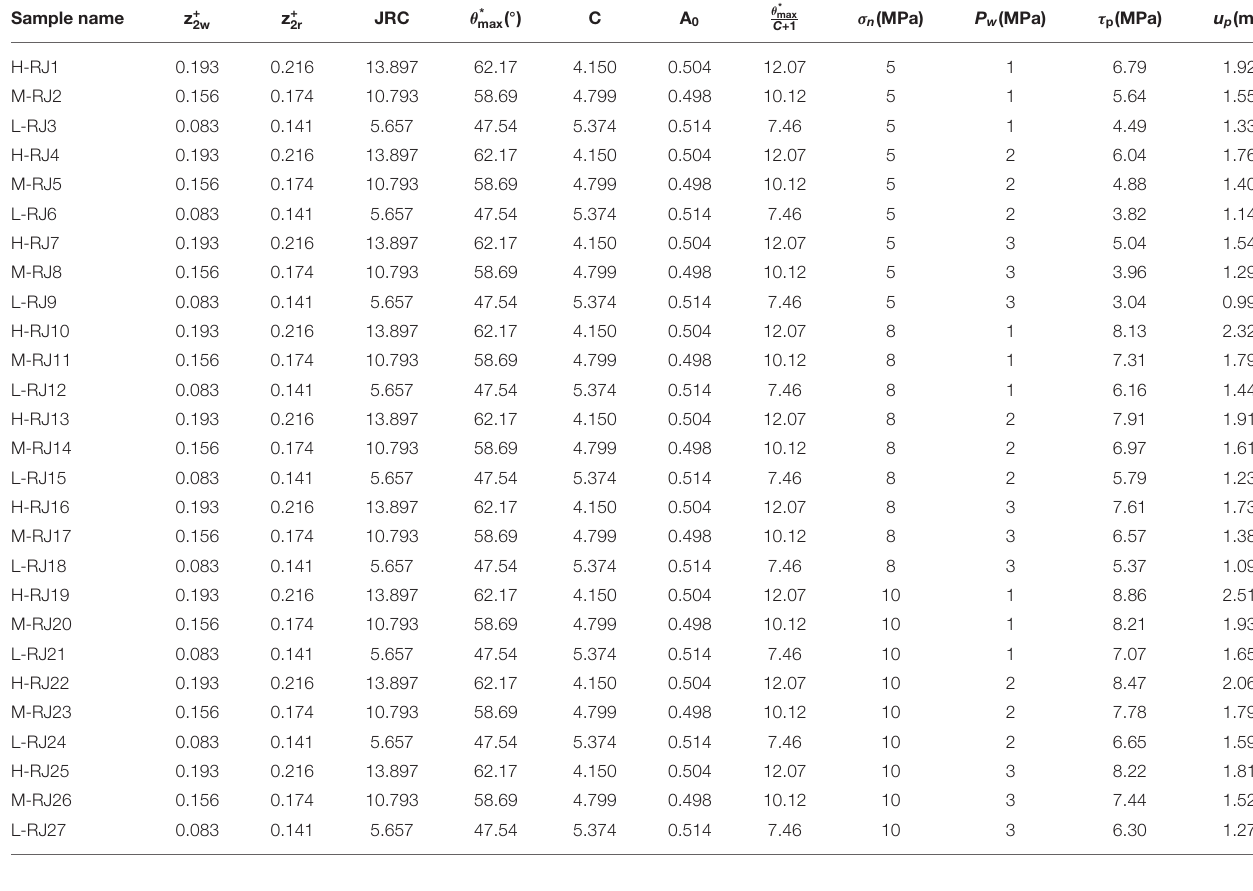
TABLE 1 | Roughness parameters of different types of joint samples and direct shear test results.